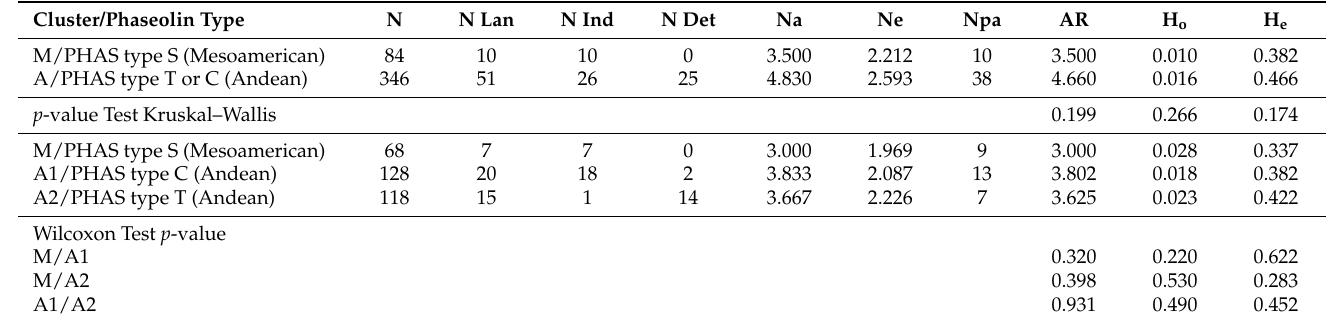
Table 1. Genetic diversity of landraces classified into two and three groups according to model cluster analysis and PHAS type. N: number of individuals for each group; N land: number of landraces for each group; N Ind: number of landraces with indeterminate growth habit; N Det: number of landraces with determinate growth habit; Na: number of alleles per locus; Ne: number of effective alleles; Npa: number of private alleles; AR: allelic richness; H o : observed heterozygosity; H e : expected heterozygosity.